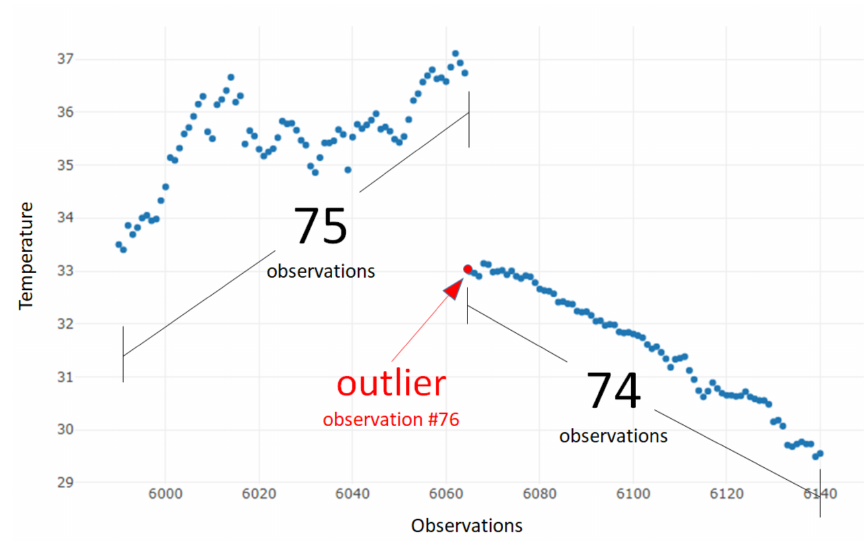
Figure 4. Example of a single sample vector with missing values.